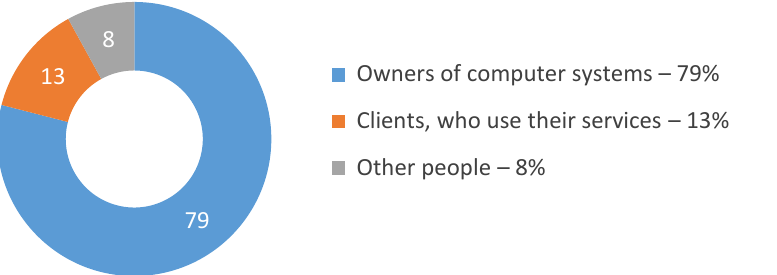
Figure 5. Information about the victim’s side of computer crimes